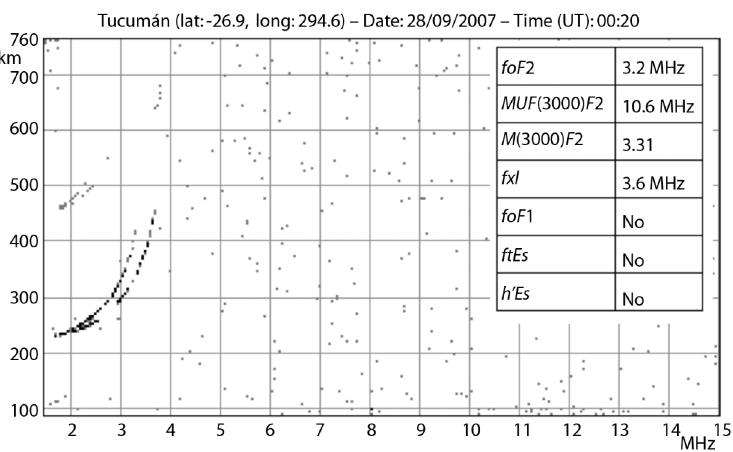
Fig. 3. An example of a nighttime ionogram recorded on 28 September 2007 at 00:20 UT by the AIS-INGV ionosonde installed at Tucumán, and autoscaled by Autoscala.